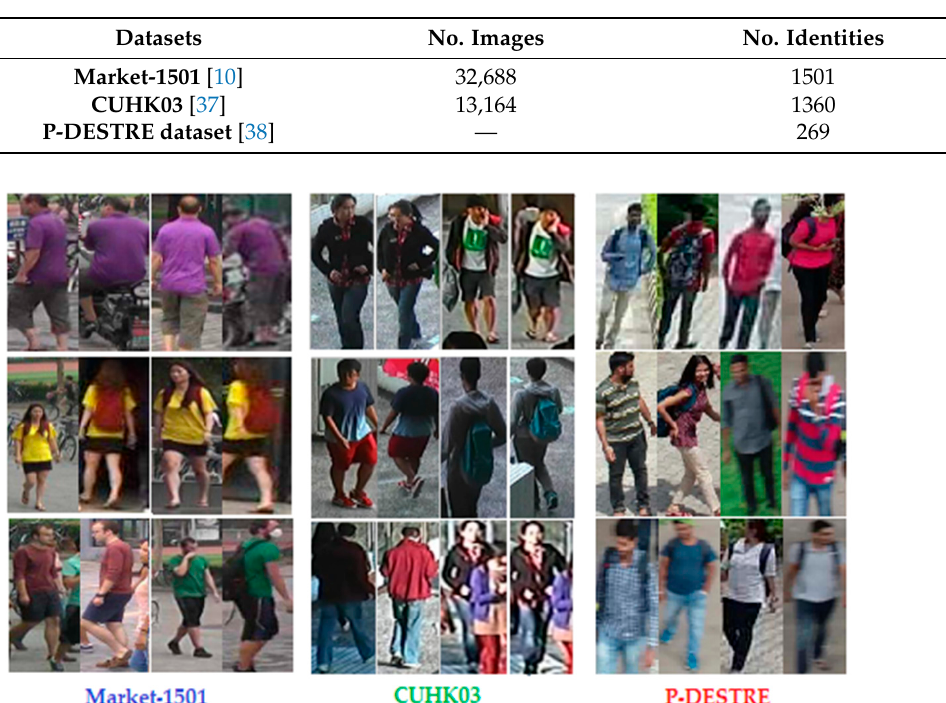
Table 1. The statistics of the adopted three Re-ID datasets.